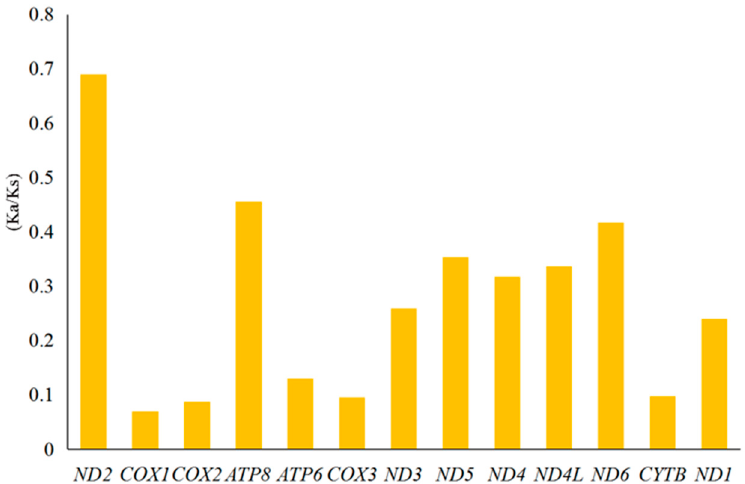
Figure 5. Evolutionary rates of PCGs in bark beetle mitogenomes in Scolytinae. The y-axis indicates the Ka/Ks ratio of mitochondrial PCGs and the x-axis indicates 13 genes encoding proteins in mitochondria.